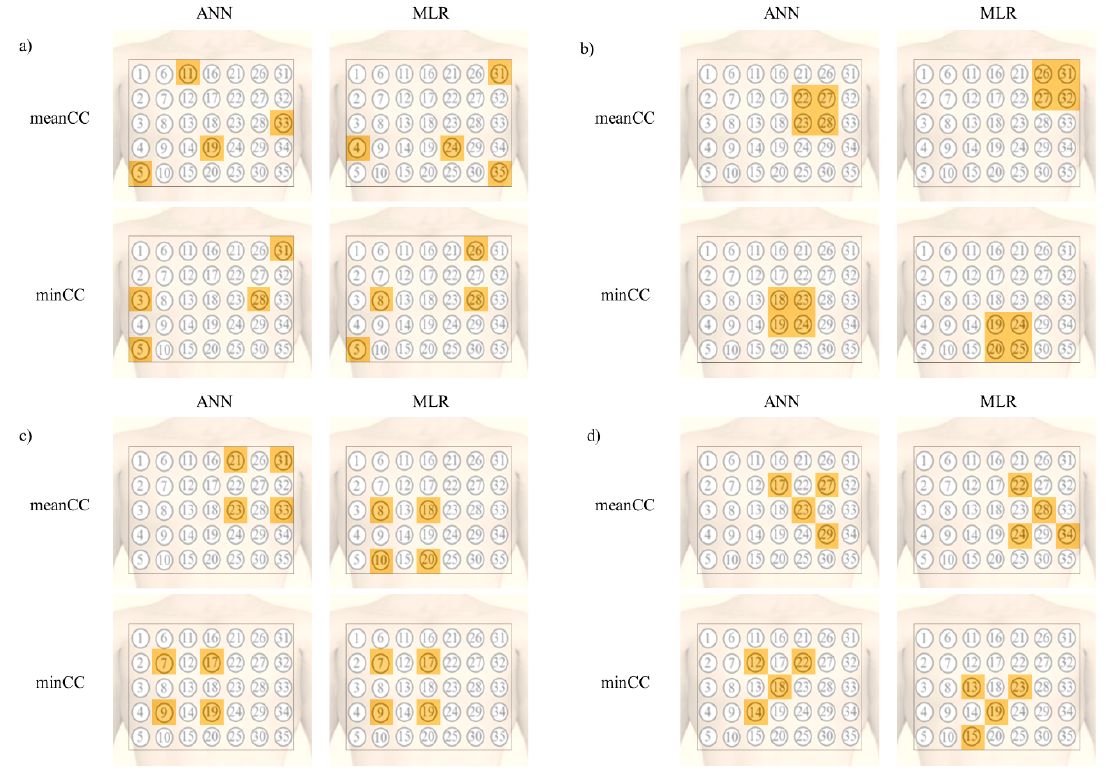
Figure 3. Electrode combination that showed the highest CC for each shape; ( a ) all electrode combinations, ( b ) 5 cm × 5 cm square shape combination, ( c ) 10 cm × 10 cm square shape combinations, and ( d ) right-angled triangular shape combinations.